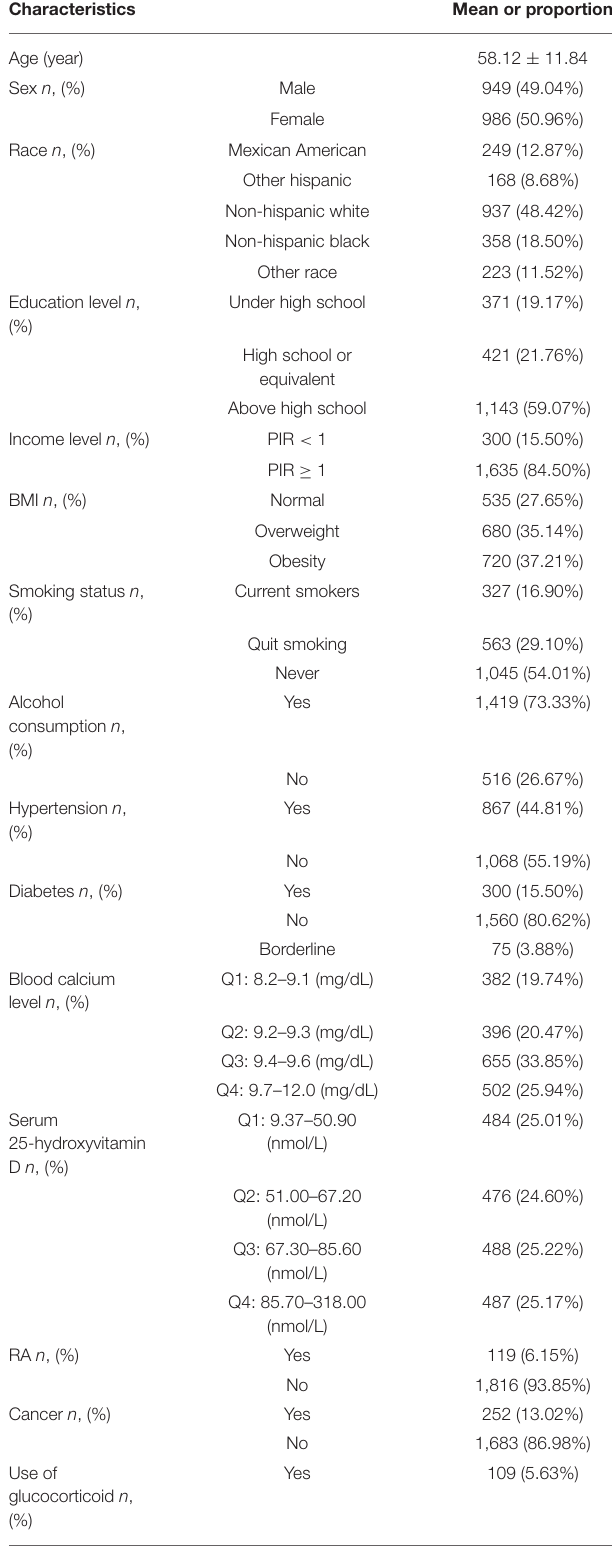
TABLE 1 | Baseline characteristics of included